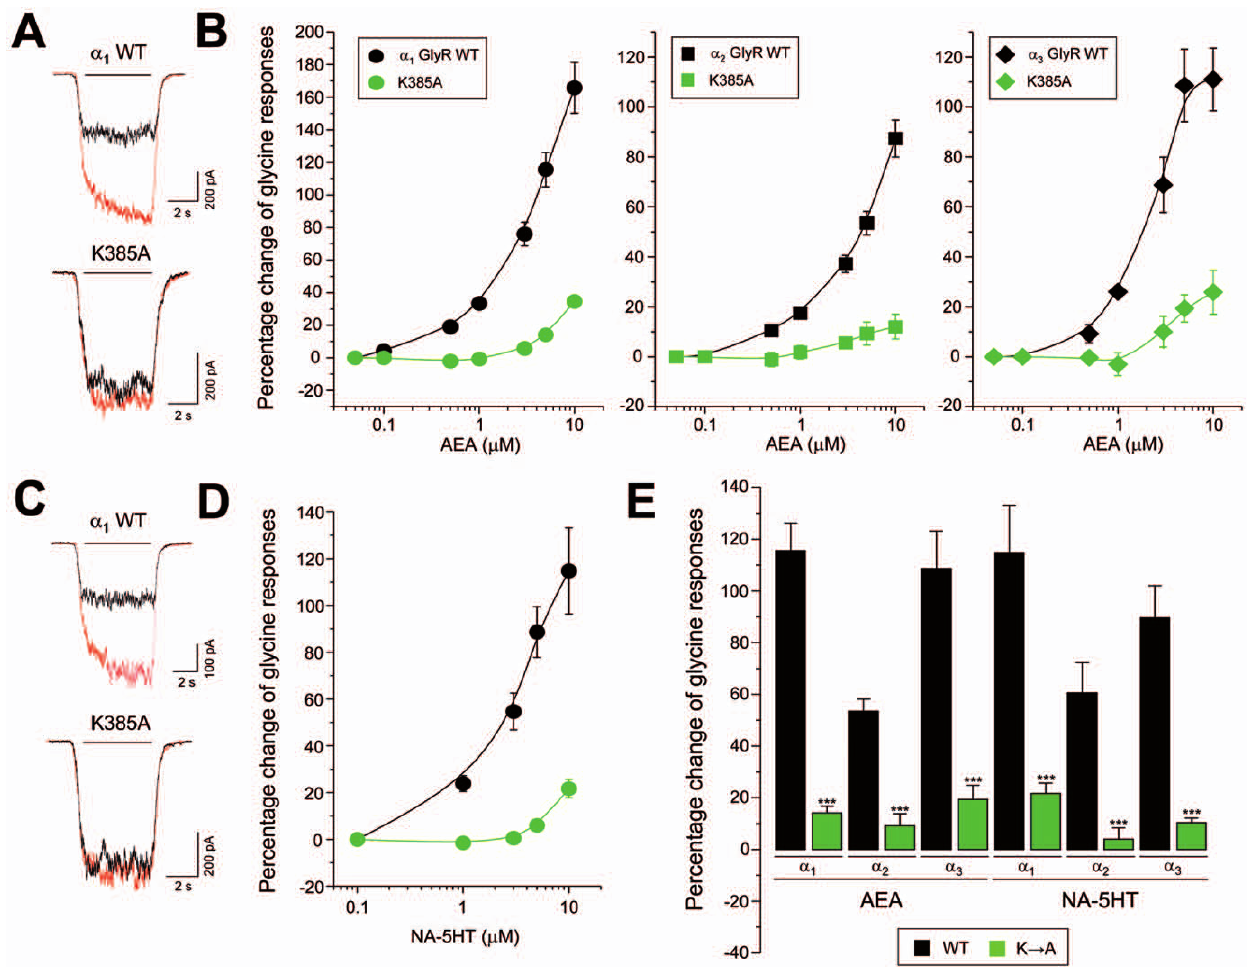
Figure 8. A conserved intracellular lysine residue determines the positive allosteric modulation by neutral ECs on GlyRs. ( A ) Examples of current traces through wild-type a 1 GlyRs and K385A mutated GlyRs in absence (black) or presence of AEA (5 m M, red) ( B ) Sensitivity to AEA of the normalized glycine-activated currents in wild-type and K385A-mutated GlyRs. The intracellular mutation effectively attenuated the AEA- induced modulation of the three GlyR subunits. ( C ) Glycine-activated current traces from wild-type or K385A-mutated a 1 GlyRs before (black) and during the application of NA-5HT (5 m M, red) ( D ) Concentration-response curves for NA-5HT obtained from wild-type and K385-mutated a 1 GlyRs ( E ) Summary of the allosteric effects elicited by AEA and NA-5HT in wild-type and K385A-mutated GlyRs. The current potentiation was significantly attenuated by the intracellular mutation. ***, P , 0.001 between each wild-type GlyR and its corresponding K385A mutant.